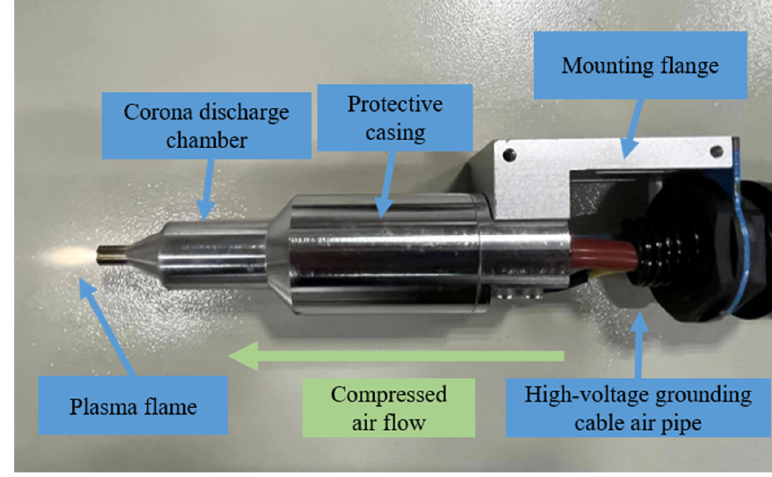
Figure 5. Physical diagram of low-temperature plasma spray gun.